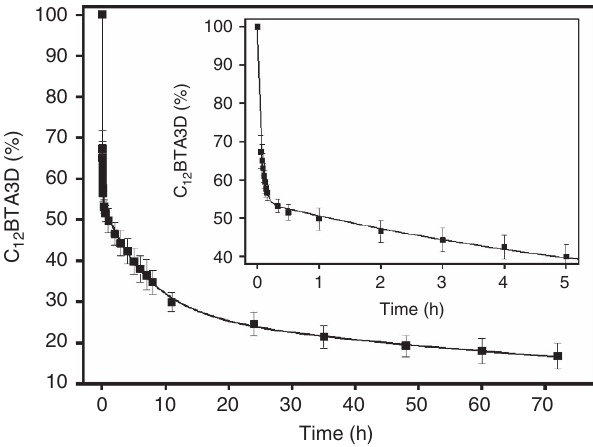
Figure 3 | Time-dependent exchange experiment. Percentage of C 12 BTA3D as a function of time after the dilution of a 500 m M BTA solution 100 times into D 2 O, at room temperature. The black line is a tri-exponential fit of the experimental data including the point ( t ¼ 0h, C 12 BTA3D ¼ 100%), with k initial ¼ 1.8 (cid:3) 10 1 h (cid:4) 1 , k fast ¼ 1.4 (cid:3) 10 (cid:4) 1 h (cid:4) 1 and k slow ¼ 0.7 (cid:3) 10 (cid:4) 2 h (cid:4) 1 . The error bars represent one s.d. of uncertainty computed from three separate kinetic experiments. The inset shows an enlargement of the data points and fit for the first Time-resolved H/D exchange of C 12 BTA supramolecular polymer . The significantly reduced exchange rate with time prompted us to analyse the dynamics in more detail and at longer timescales.